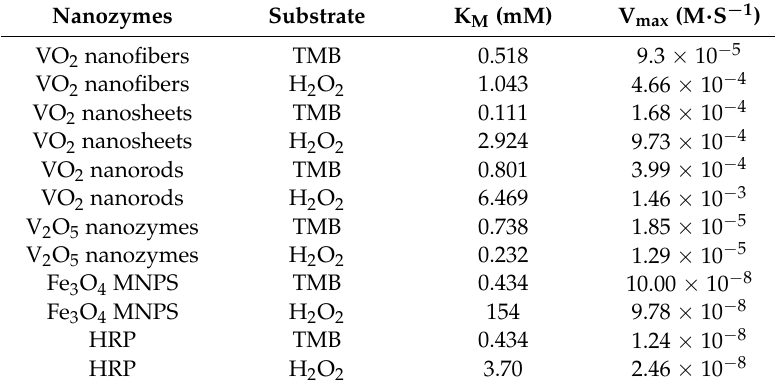
Table 1. Comparison of the K M and V max of VO 2 nanozymes, V 2 O 5 nanozymes, Fe 3 O 4 MNP S , and HRP, respectively.